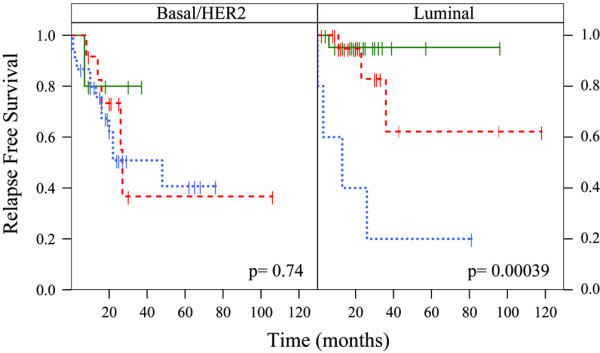
Intrinsic subtype stratified by the proliferation index. Tumors were given an 'intrinsic' subtype assignment based on the minimal 37-gene quantitative reverse-transcription-PCR classifier (Figure 1b). Patients were classified as having Luminal (estrogen receptor (ER)-positive) or HER2/Basal (ER-negative) subtypes. In order to have groups of similar size and because the subtypes largely follow ER status, tumors in the HER2 and Basal-like groups (both ER-negative) were combined. Continuous expression data for the proliferation meta-gene (log2 average of the 14 selected markers) were used in a Cox regression model to determine the probability of relapse over time. Differences in relapse for low (green), medium (red), and high (blue) expression are shown as tertiles in the Kaplan-Meier plots. Stratification by proliferation added information for relapse in the Luminal subtype (P = 0.00039) but not the ER-negative subtypes (P = 0.74).